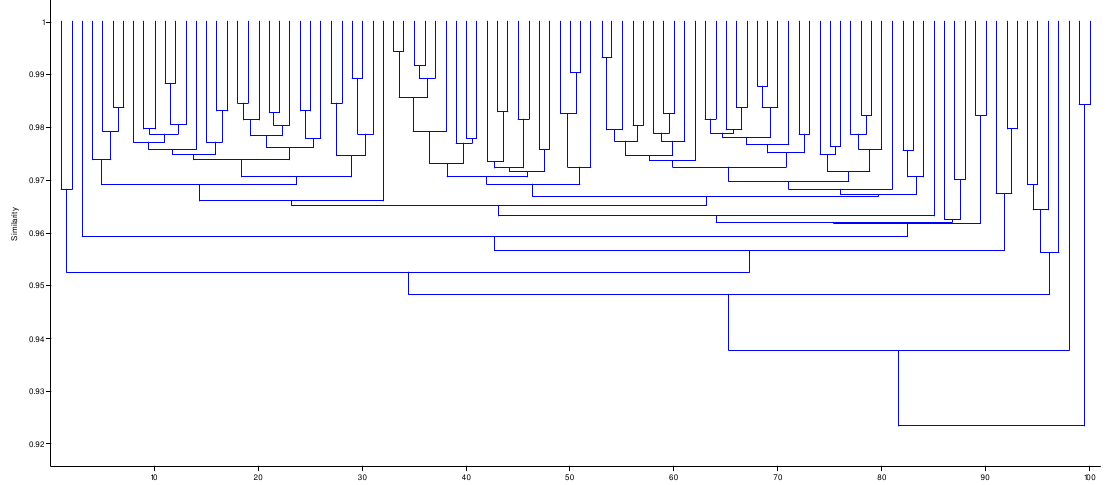
Fig. 3. Dendrogram showing similarity coefficient (92.4%) of the morphometrics of wild and cultured samples of Clarias gariepinus employing the Bray-Curtis’s clustering algorithm * Blue color indicates wild samples, while green color indicates cultured samples